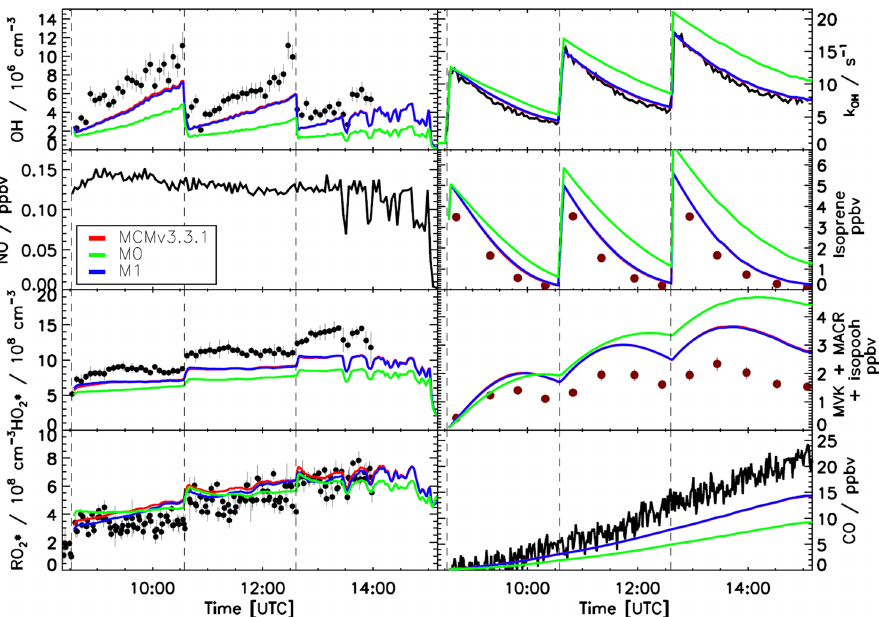
Figure 4. Comparison of modelled and measured trace gases for an experiment with NO < 0 . 2ppbv. Measured time series of radicals and OH reactivity (LIF), isoprene and MVK + MACR + ISOPOOHs (GC), and CO (Picarro) are compared to model calculations. Vertical dashed lines indicate the times when isoprene was injected. No good agreement is observed when using the MCMv3.3.1 or a modified version (M1, Table 2) including isoprene-RO 2 conformer equilibrium reactions as included in the Caltech mechanism. Error bars represent 1 σ standard deviation.